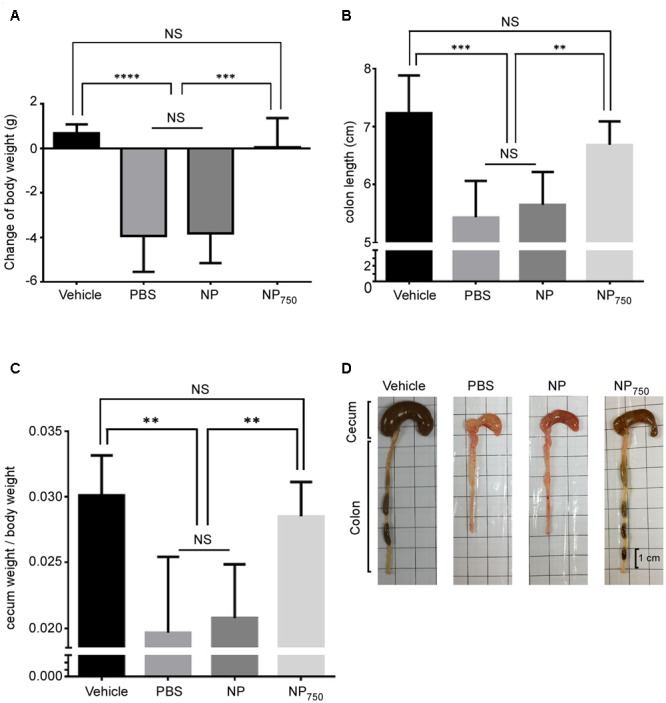
Protection against purified C. difficile spores challenge in vaccinated mice. Various groups of mice were treated with an antibiotic cocktail and then challenged by C. difficile or PBS only for 2 days. Body weight change (A), colon length (B), cecum weight (C), and gross views of cecum and colon (D) were assessed. Vehicle: non-immunized and non-infected group; PBS: mock-immunized and infected group; NP: empty nanoparticle immunized and infected group; NP750: vaccine immunized and infected group. All data are representative of at least three independent experiments. All data are presented as mean ± standard deviations and statistical comparisons among groups were analyzed by Student’s t-test (∗∗p ≤ 0.01, ∗∗∗p ≤ 0.001). NS = not significant.